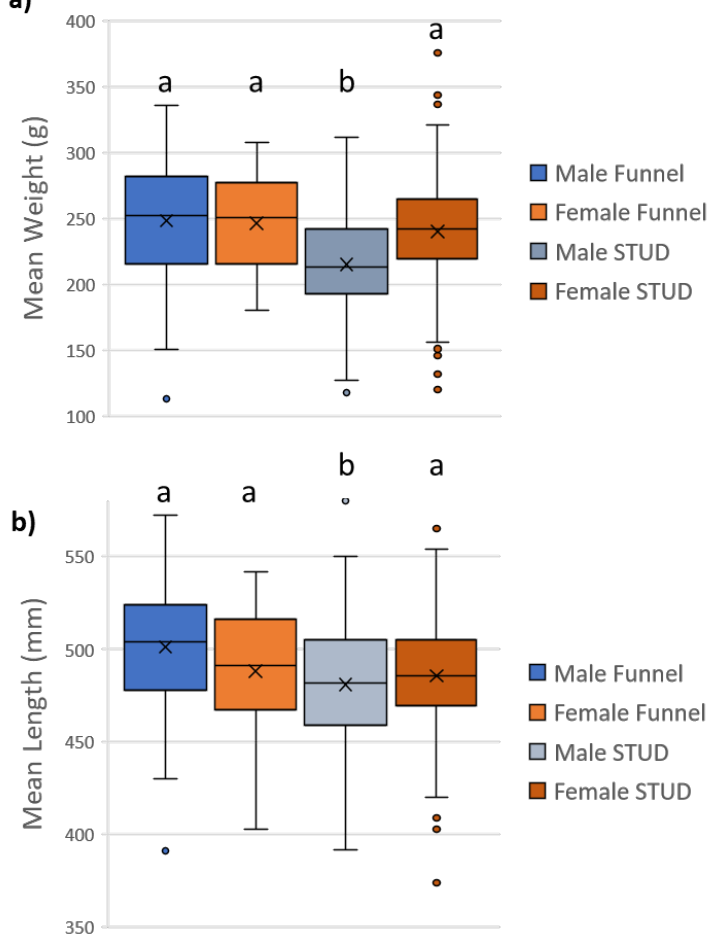
Figure 4. Mean weight ( a ) and length ( b ) of sea lamprey recaptured in two trap types in the Cheboygan River. Column marked with different letters had significantly different means in a Tukey ’s test.